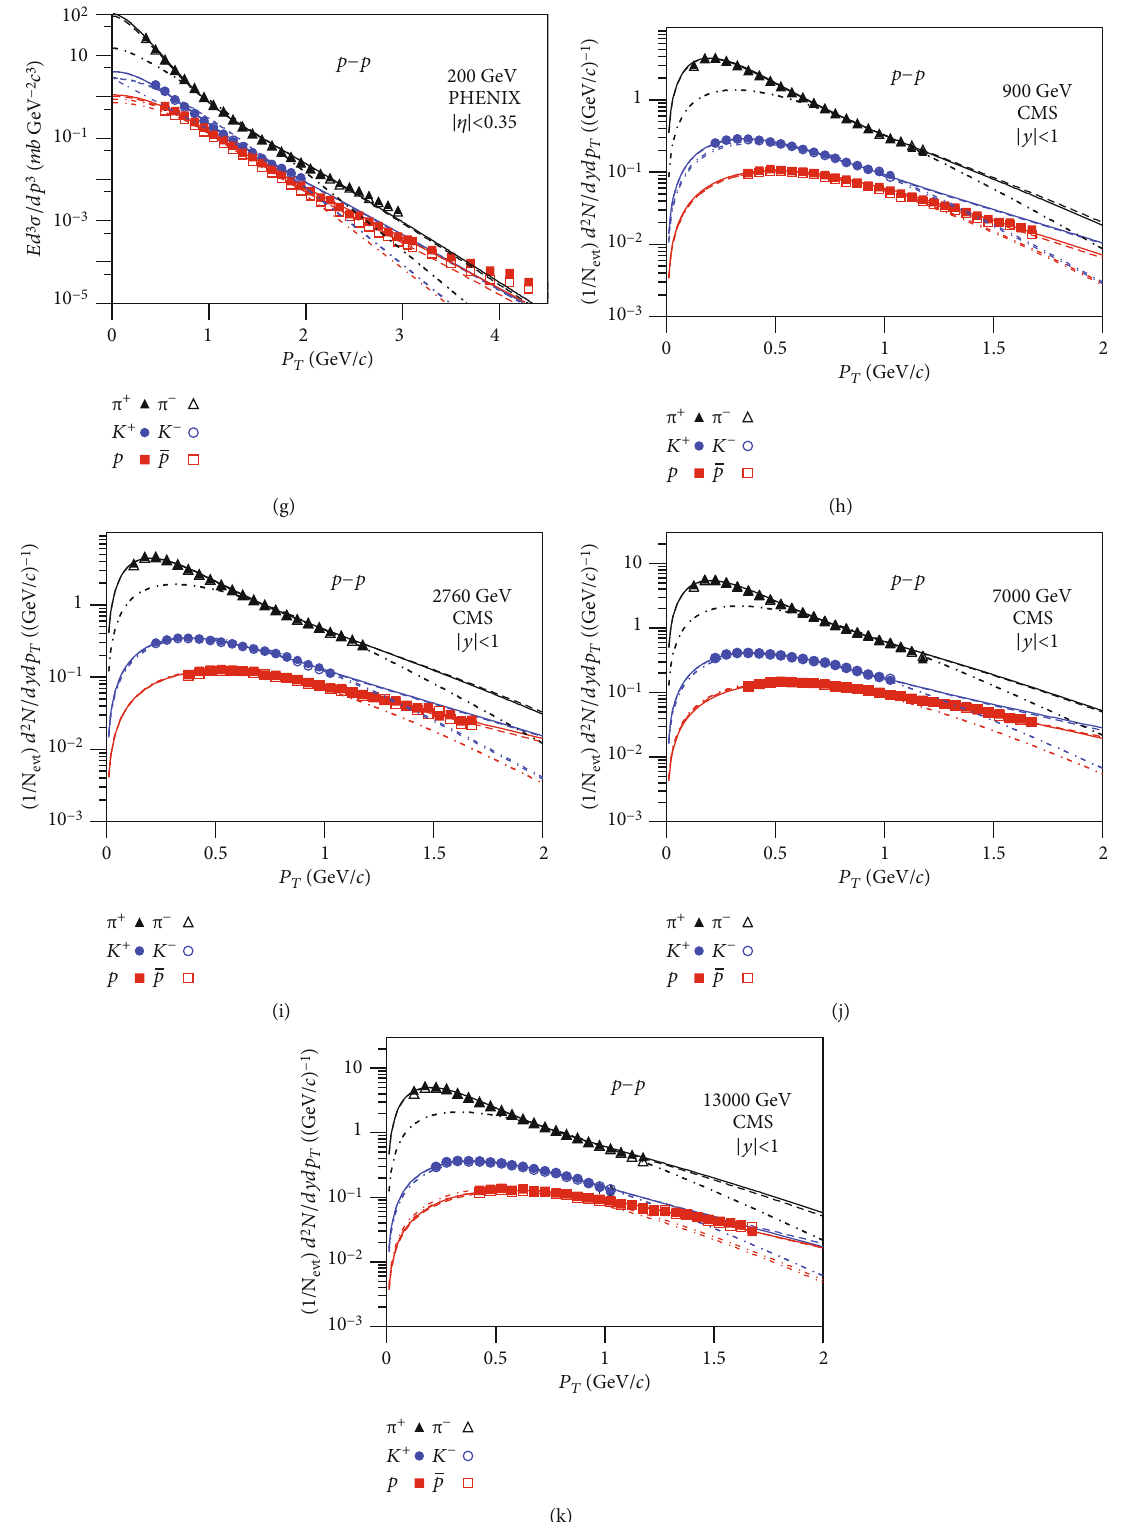
Figure 3: Same as Figure 1 but showing the spectra of various particles produced at mid- y or mid- η in INEL pp collisions at high center-of- ffiffi p s mass energies , where the factor ð 1/2 π p T Þ on the vertical axis is removed and the invariant cross-section Ed 3 σ / dp 3 is used in some cases. The symbols represent the experimental data measured by (a – e) the NA61/SHINE [39, 40], (f, g) the PHENIX [41], and (h – k) the CMS [42, 43] Collaborations, where panels (g – k)